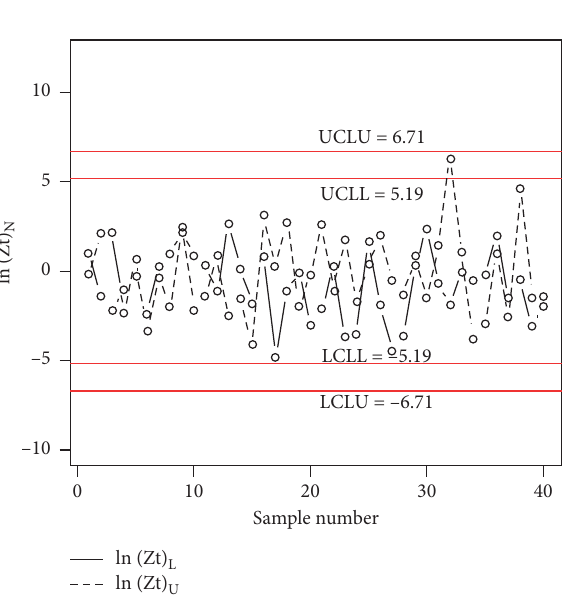
Figure 5: Aslam et al. [44] chart for UTI